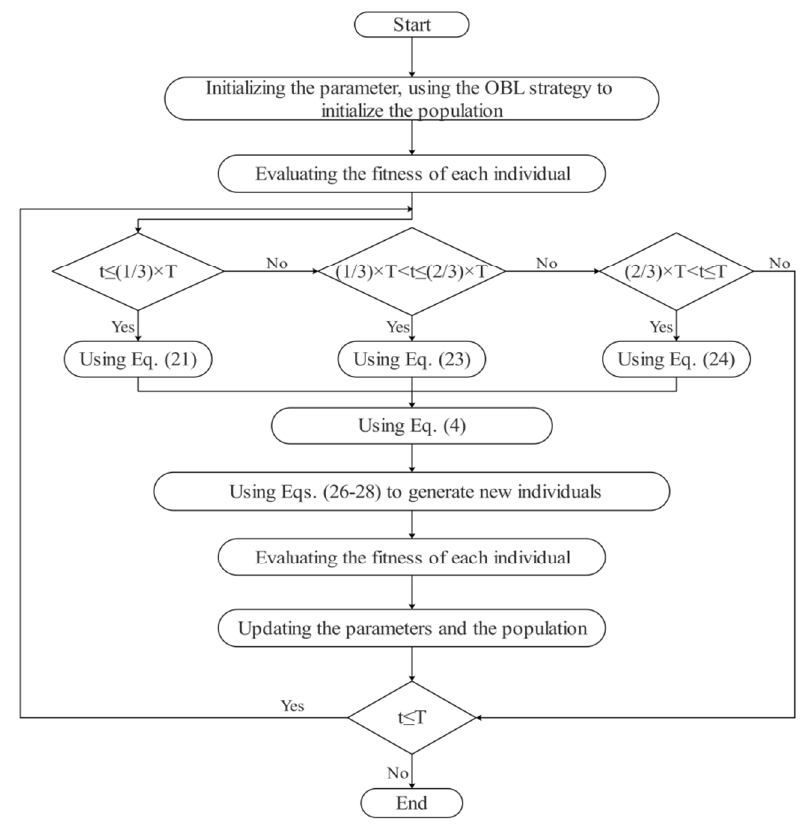
Figure 3. The flowchart of the SSDE.